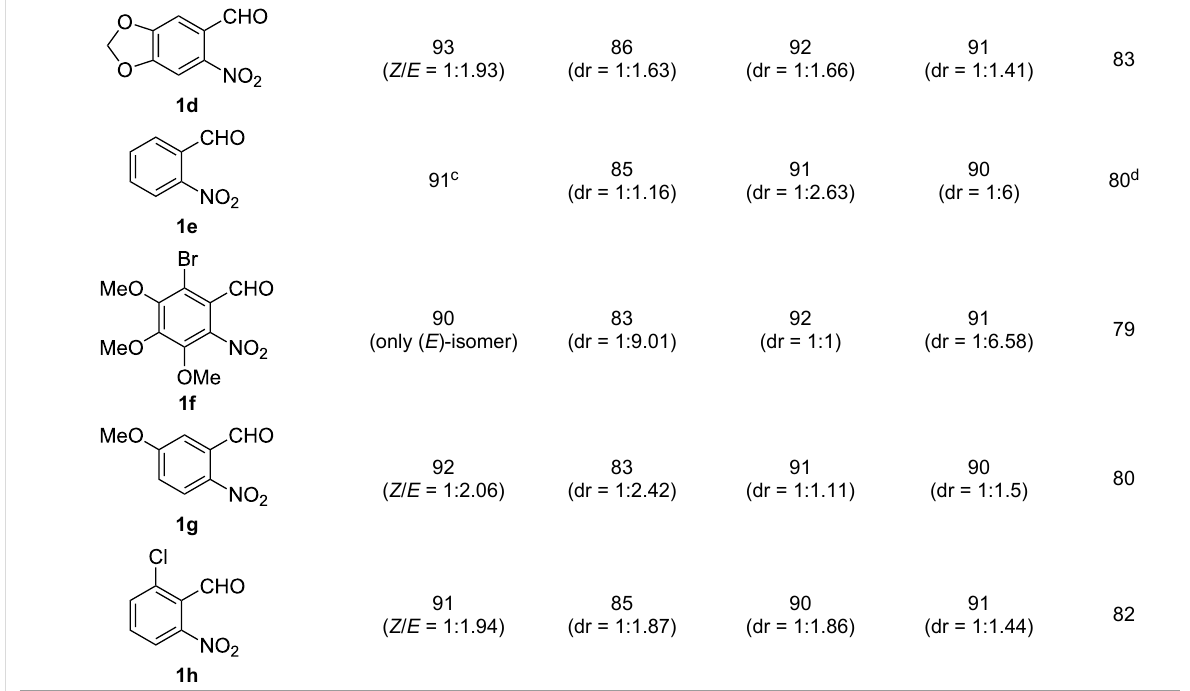
Table 1: Synthesis of 3-methylquinoline-4-carbaldehydes.